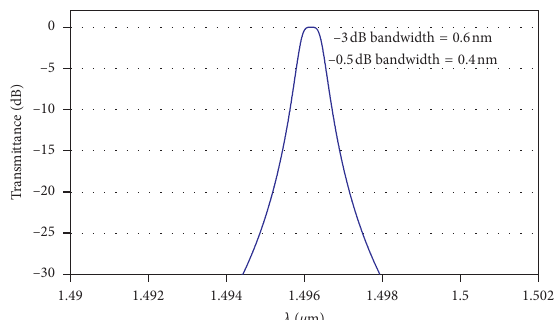
Figure 4: The channel shape profile for the LC refractive index ( n � 1.5).